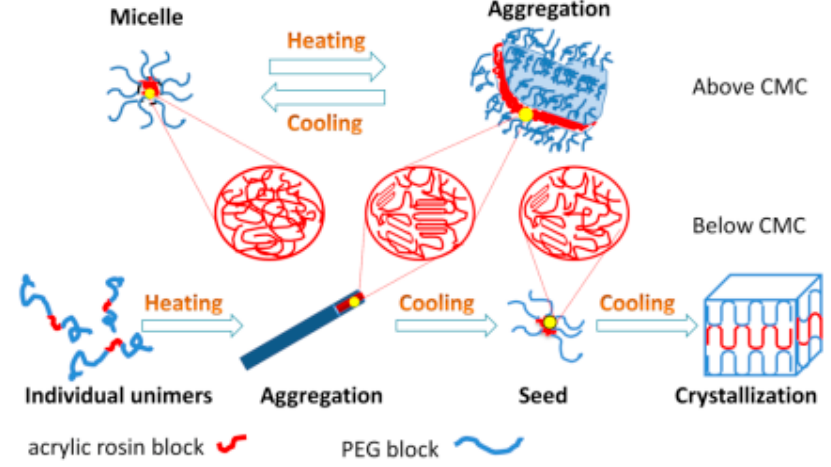
Figure 9. Schematic diagram of conformational changes for various PEG-acrylic rosin polymer solutions in a heating and cooling cycle.